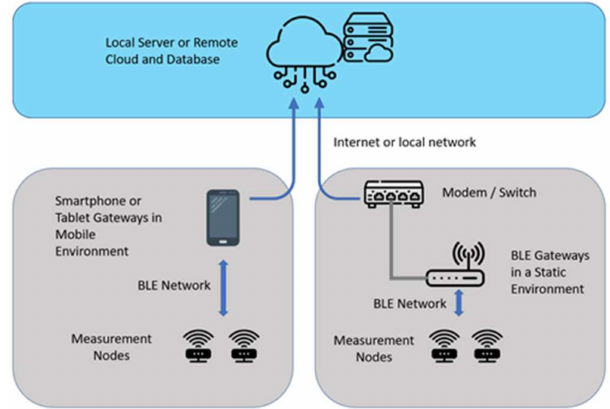
Figure 3. Data collection network